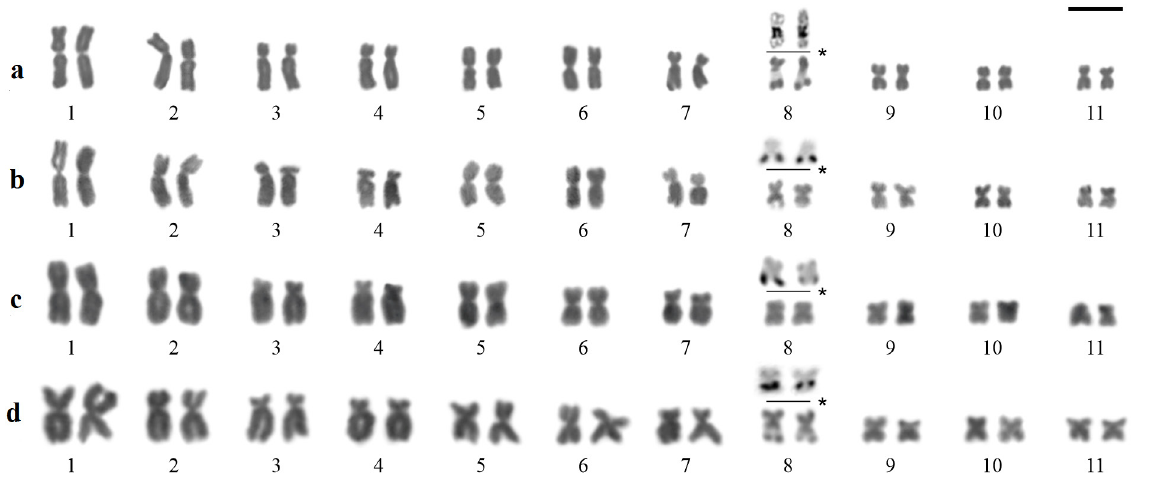
Figure 1. Giemsa stained karyotypes of four species of the Physalaemus gracilis group. (a) P. carrizorum , (b) P. gracilis , (c) P. sp. aff. gracilis , (d) P. lisei . The insets (*) show chromosomes with Ag-NORs. Bar = 10